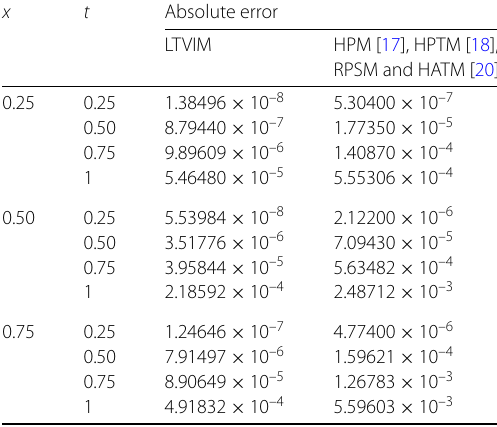
Table 2 Comparison of LTVIM, HPM [17], HPTM [18], RPSM and HATM [20] on Example 4.2. Here α = 1 is used for all methods x t Absolute